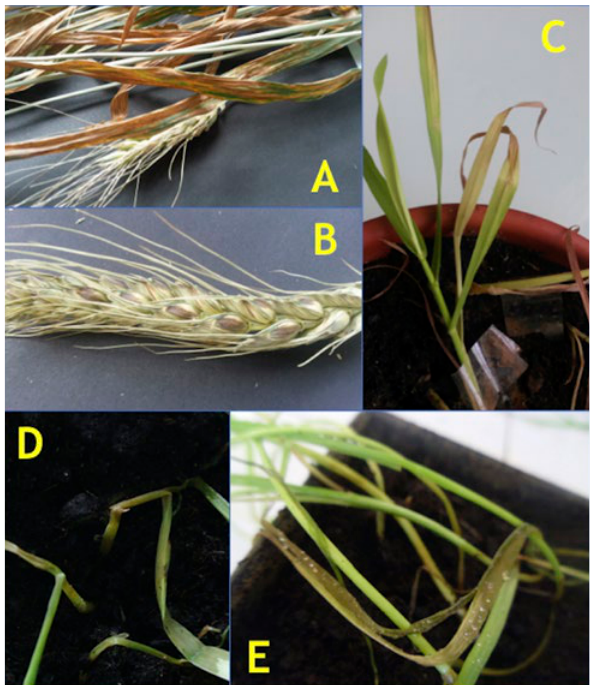
Figure 1. Disease symptoms on wheat. (A) Symptoms of bacterial leaf streak at the heading stage, (B) symptoms of black chaff at the heading stage, (C) chlorotic to necrotic lesions from leaf infiltra- tion 7 d after inoculation, (D) disease symptoms 8 d after pricking inoculation of wheat seedlings at the three-leaf stage, and (E) water- soaked spots associated with bacterial exudates 8 d after dip inocu- lation of